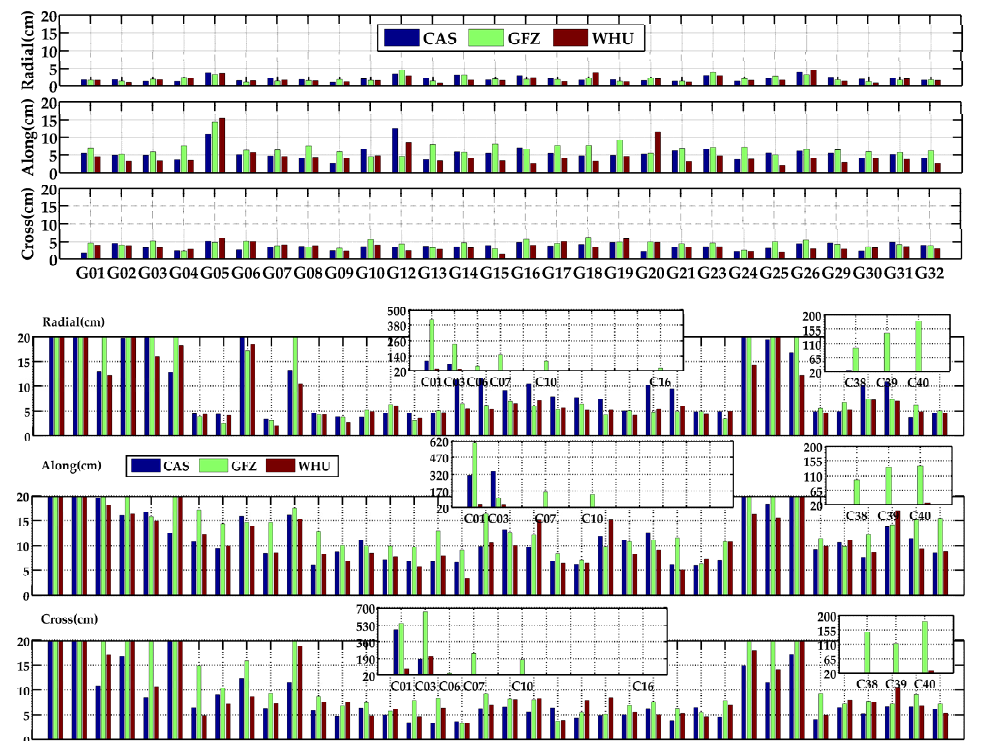
Figure 6. Orbit RMS of real-time products of GPS satellites ( top ) and BDS satellites ( bottom ) from the three IGS analysis centers.